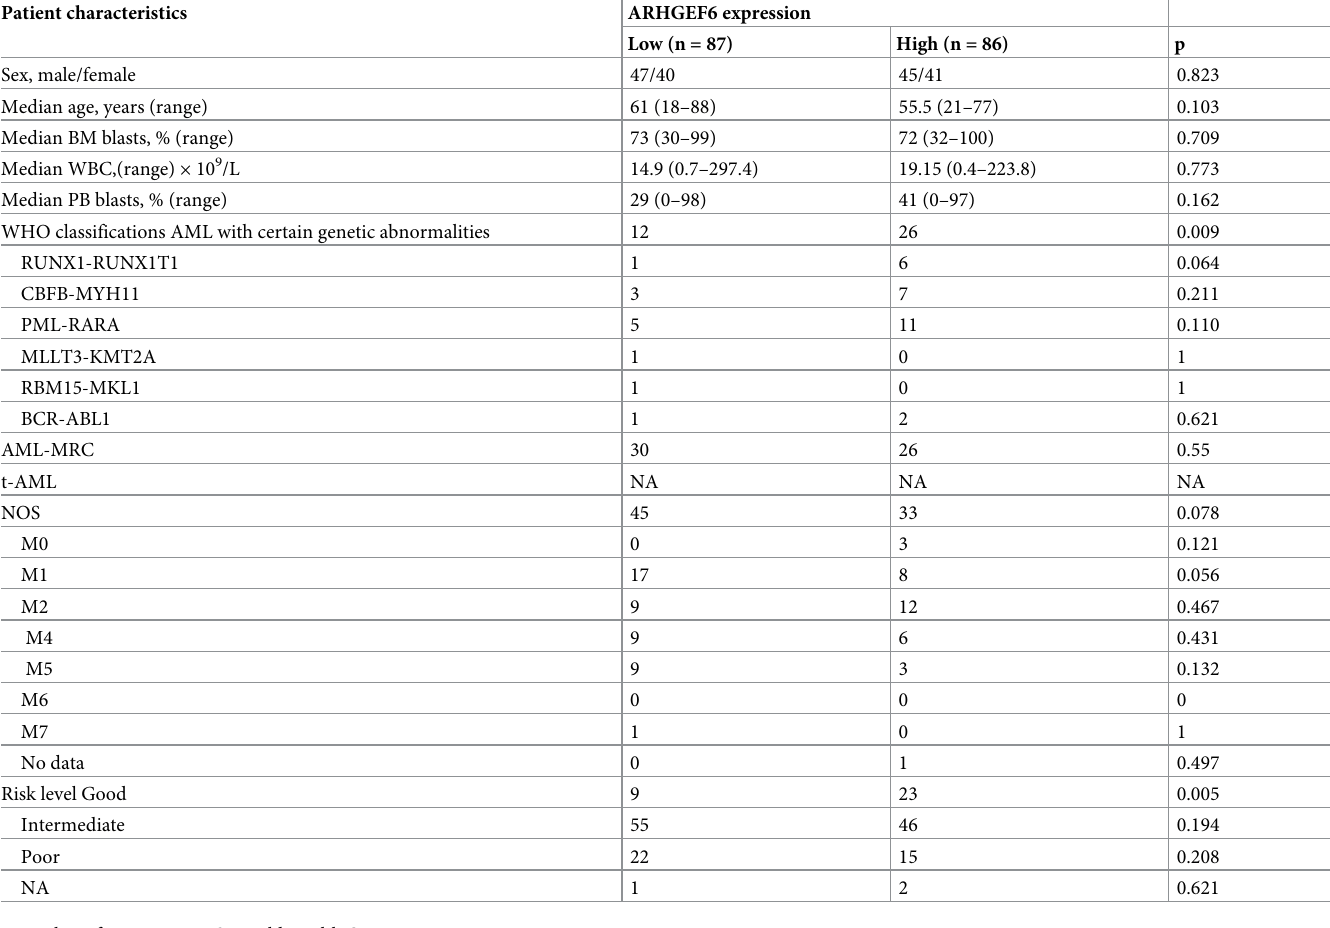
Table 1. Correlations between ARHGEF6 expression and clinicopathological characteristics in AML from the TCGA